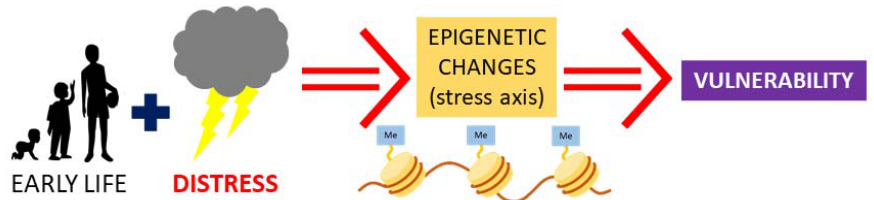
Figure 2. Schematic representation of the effect of early life stress. Epigenetic changes in AVP or AVP receptor genes modifies stress axis function and may also influence the development of vulnerabilityy to various diseases.